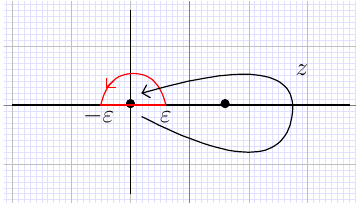
Figure 15 . Definition of b G ( z, z ) . Red: integration contour in eq.